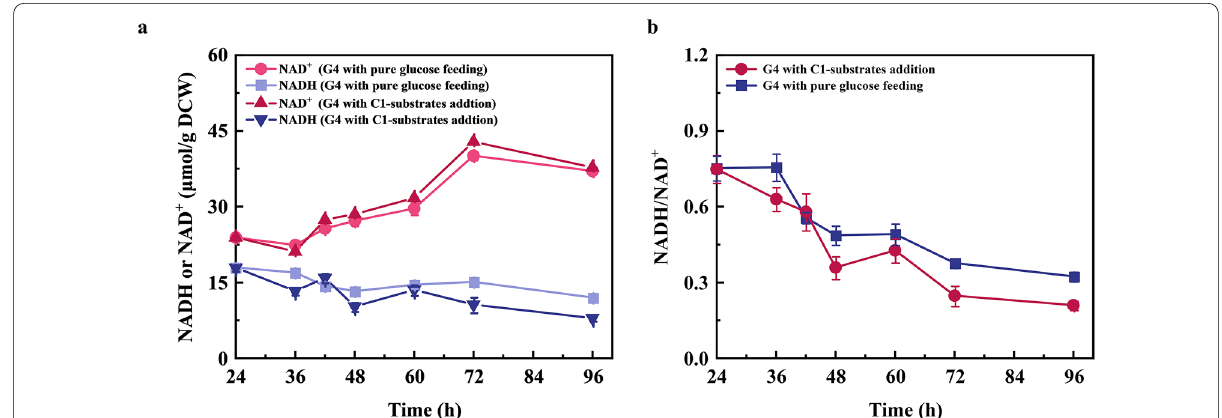
Fig. 4 Time-course of the NADH, NAD + , and NADH/NAD + ratio during fermentation. a NADH and NAD + contents; b and NADH/NAD + ratio